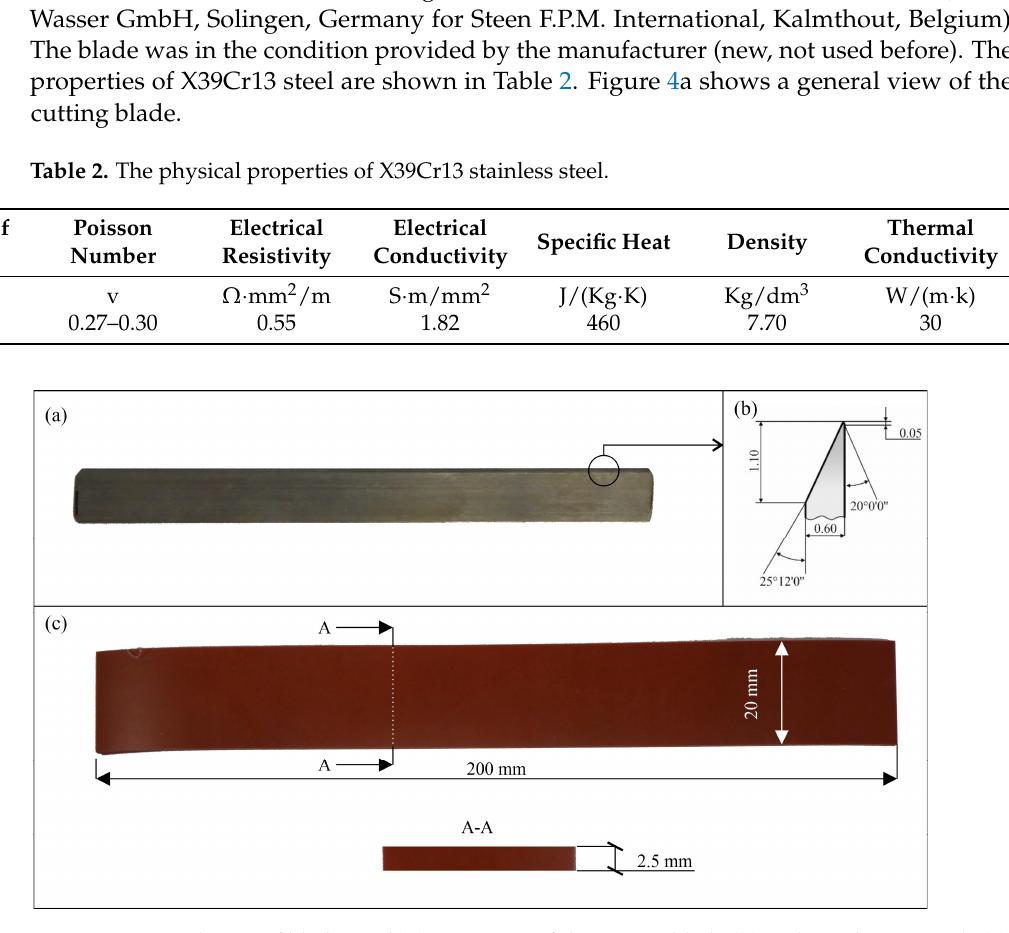
Figure 4. General view of blade used ( a ), geometry of the cutting blade ( b ), polyurethane sample ( c ). Table 3. Properties of the material (polyurethane) used as specimens in the study.